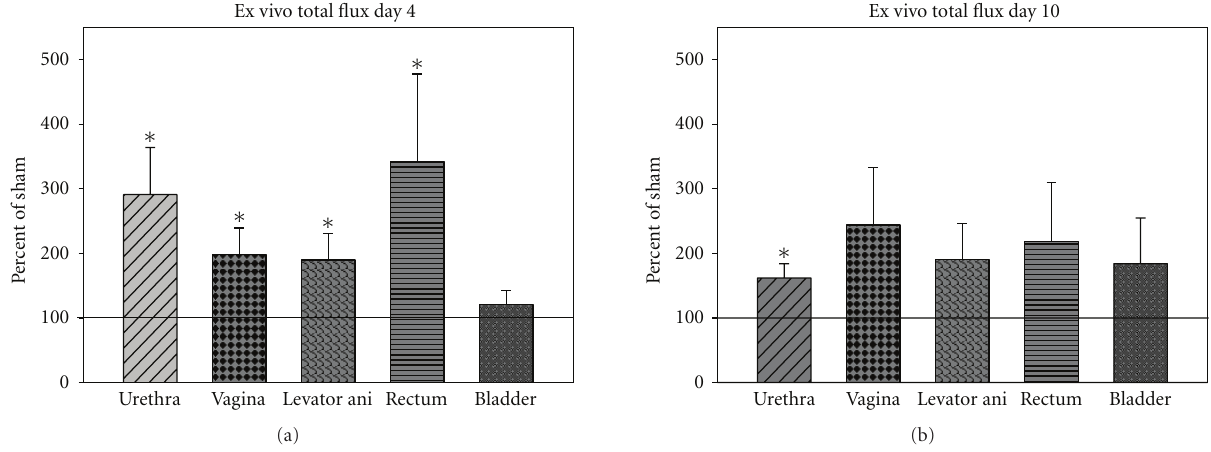
Figure 3: Relative fluorescent flux measured ex vivo (a) four days and (b) ten days after vaginal distension (VD) normalized to total fluorescent flux in paired animals that underwent sham VD simultaneously. Values are displayed as mean ± standard error of 5-6 animals/group as a percent of the sham VD values. ∗ denotes a statistically significant di ff erence compared to sham VD ( P < 0 . 05).